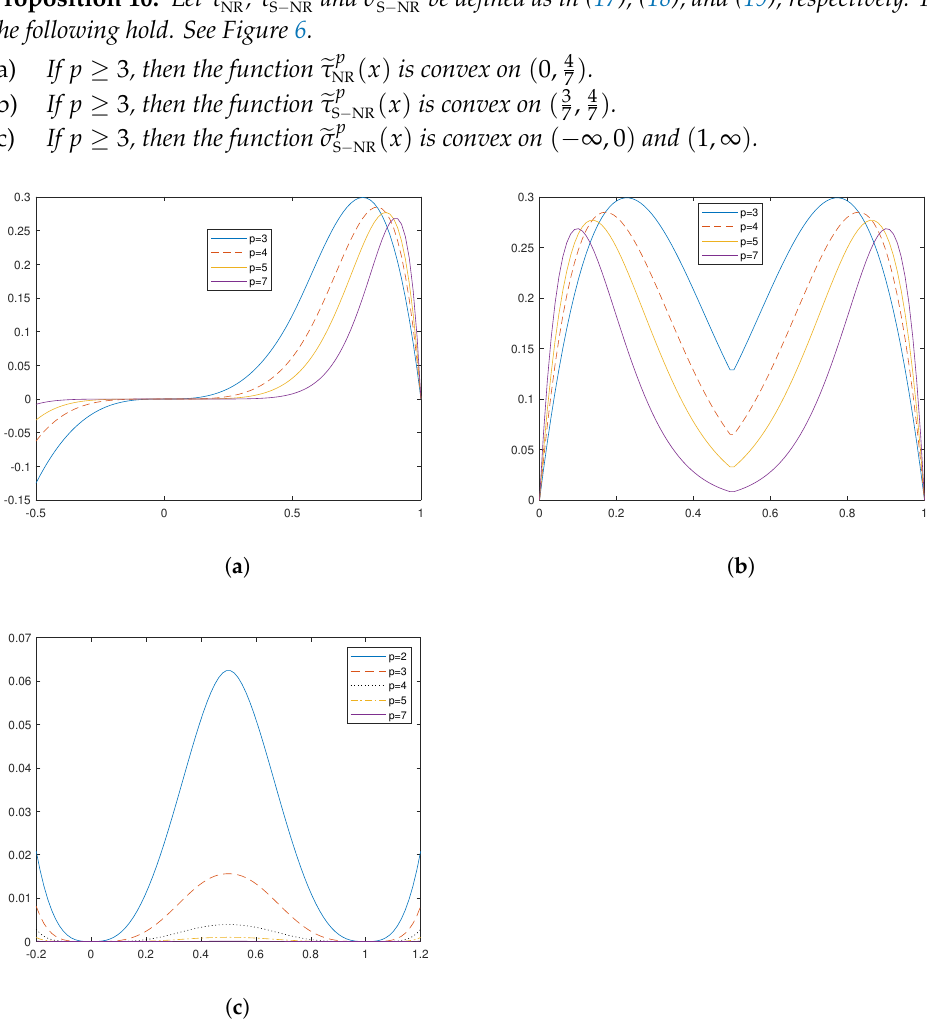
Figure 6. Graphs of (cid:101) τ p different values of p ; ( b ) Graphs of (cid:101) τ p different values of p